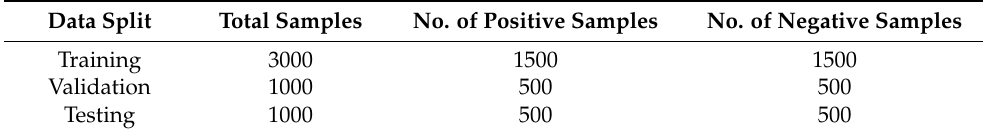
Table 1. Overview of CVC-02 data